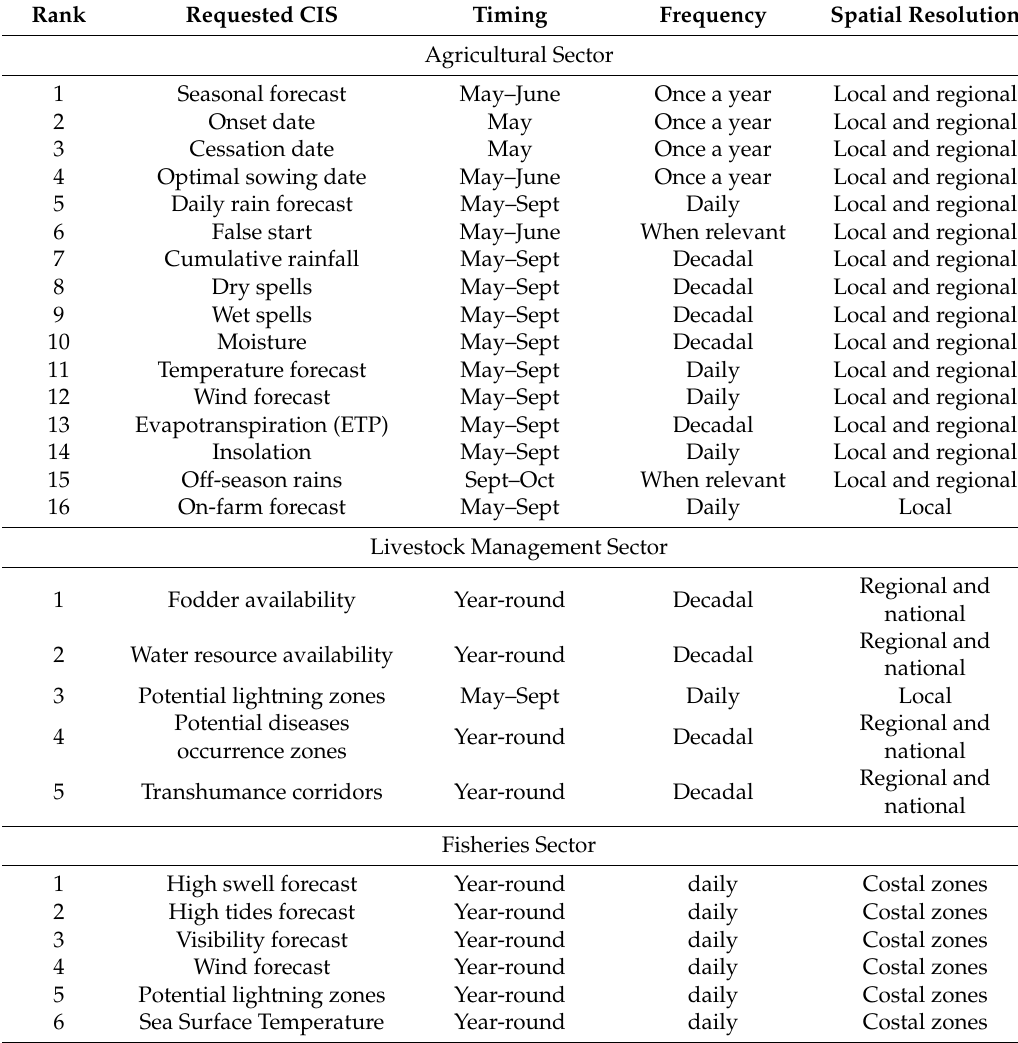
Table 1. Assessment of climate information services (CIS) needs by stakeholders (source: from